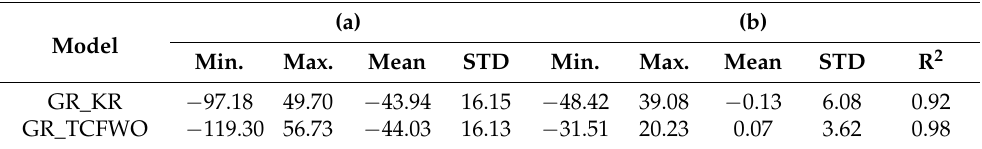
Figure 6. Cross-validation fitting regression curve, thereinto, the blue dots are 1000 validation data and red line is regress line. ( a ) Cross-validation result of GR_TCFWO model. ( b ) Cross-validation result of GR_KR model. Table 3. Statistical table of model and cross-validation information. ( a ) Information of regional gravity anomaly models. ( b ) Statistics of the difference between the estimate values and the true values of cross-validation results. (unit: